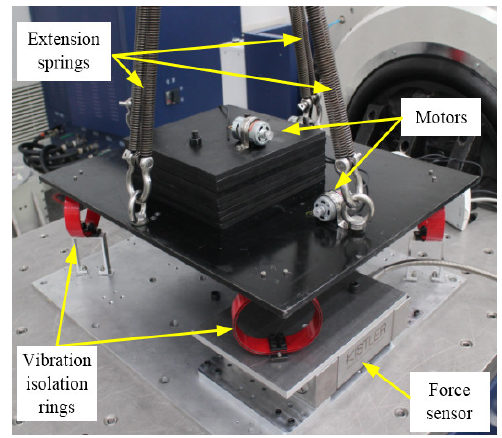
Figure 9. Transfer path analysis experiment of reaction force.